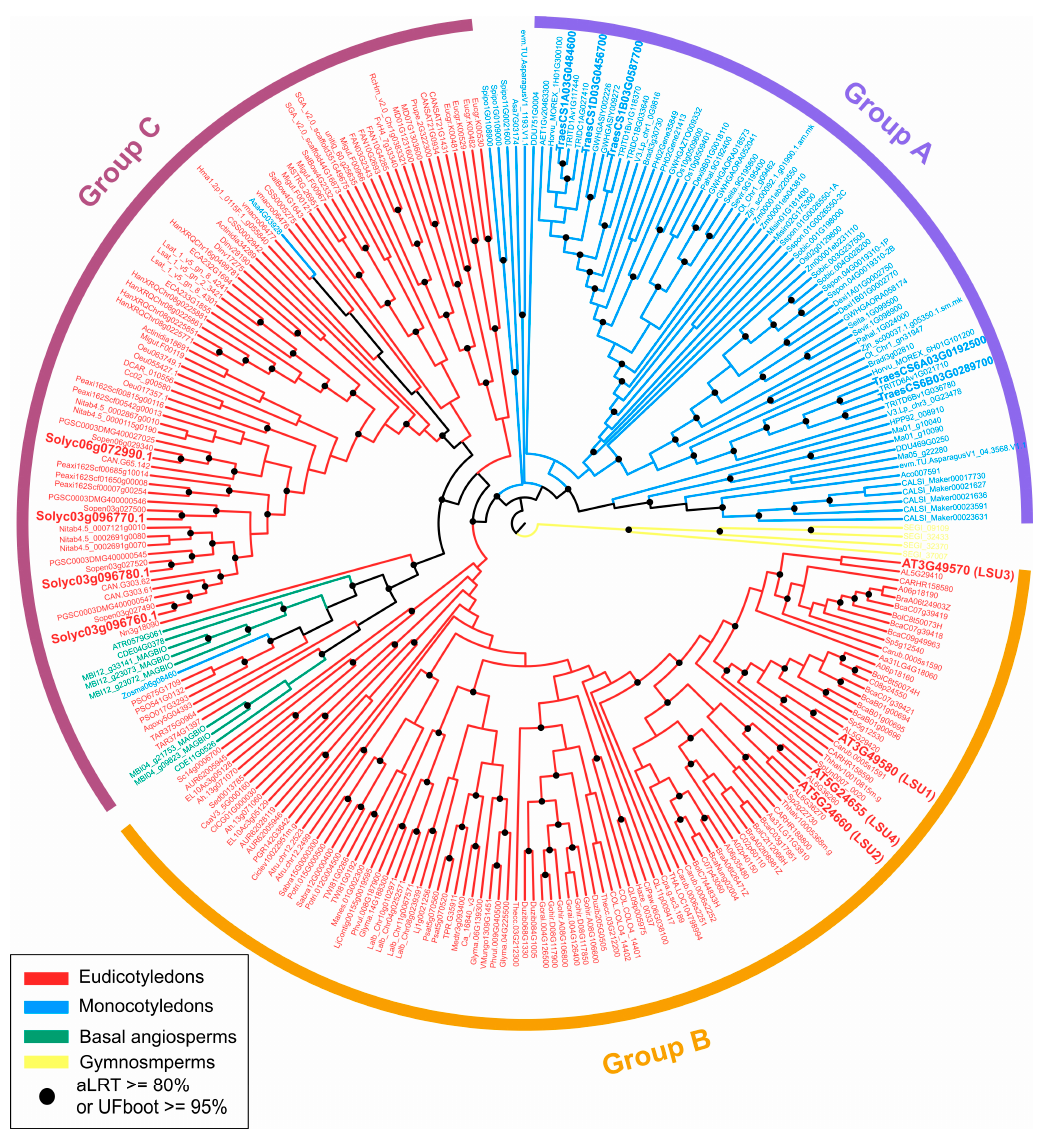
Figure 2. Phylogenetic analysis of LSU genes in angiosperm plant lineages. A phylogenetic tree was constructed using the maximum likelihood method from IQ-TREE 2 [37], supported by 10,000 boot- strap samples. Yellow lines represent gymnosperms, green lines represent basal angiosperms, blue lines represent monocotyledons and red lines represent eudicotyledons. The gene identifiers corre- spond to the PLAZA 5.0 database [35], and the complete list of LSU genes is shown in Table